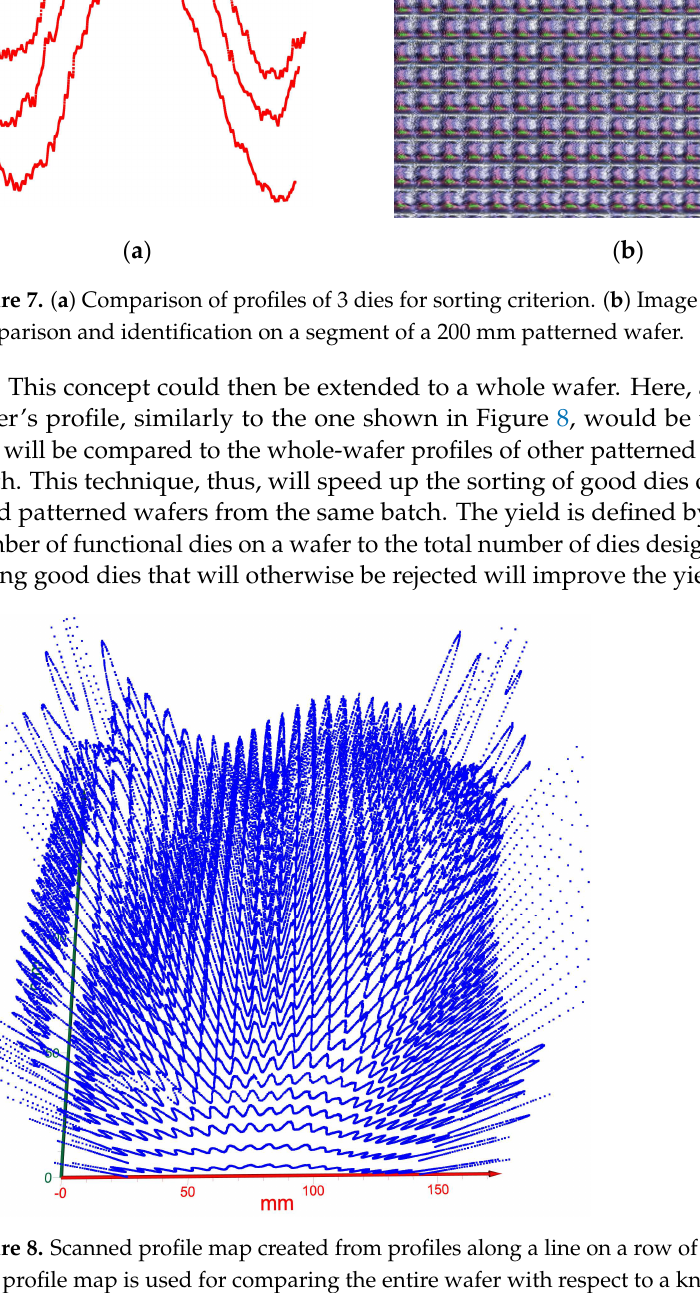
This profile map is used for comparing the entire wafer with respect to a known good wafer.